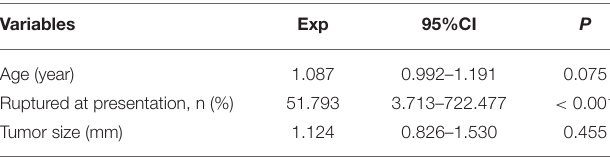
TABLE 3 | Multivariate analysis of the presence or absence of